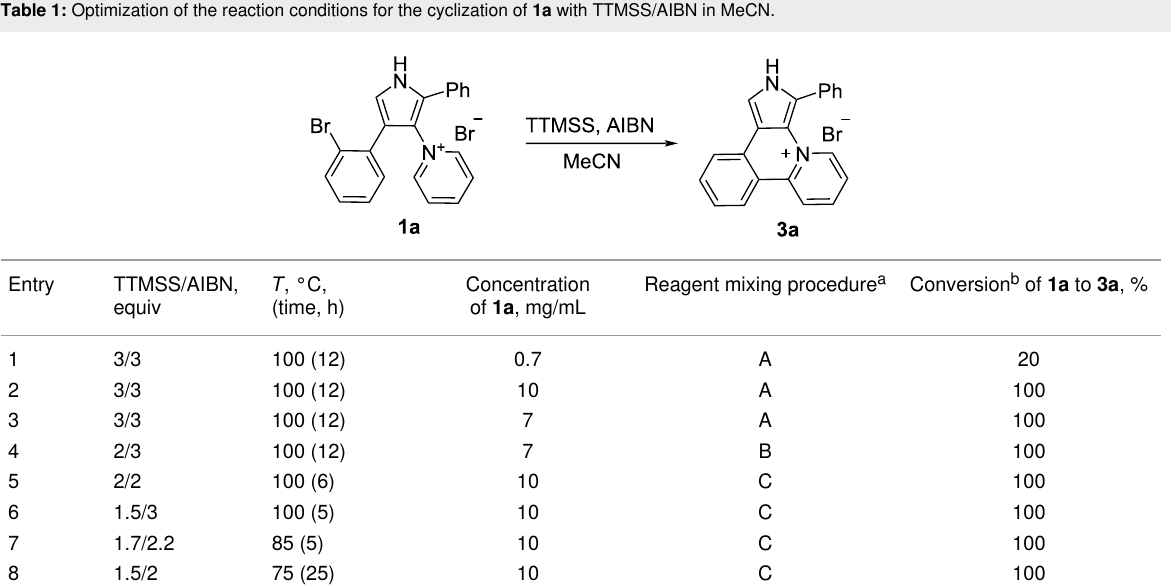
Table 1: Optimization of the reaction conditions for the cyclization of 1a with TTMSS/AIBN in MeCN.